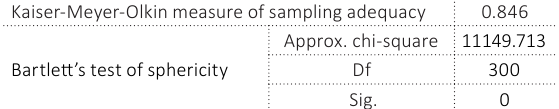
Table 2. KMO and Bartlett’s test